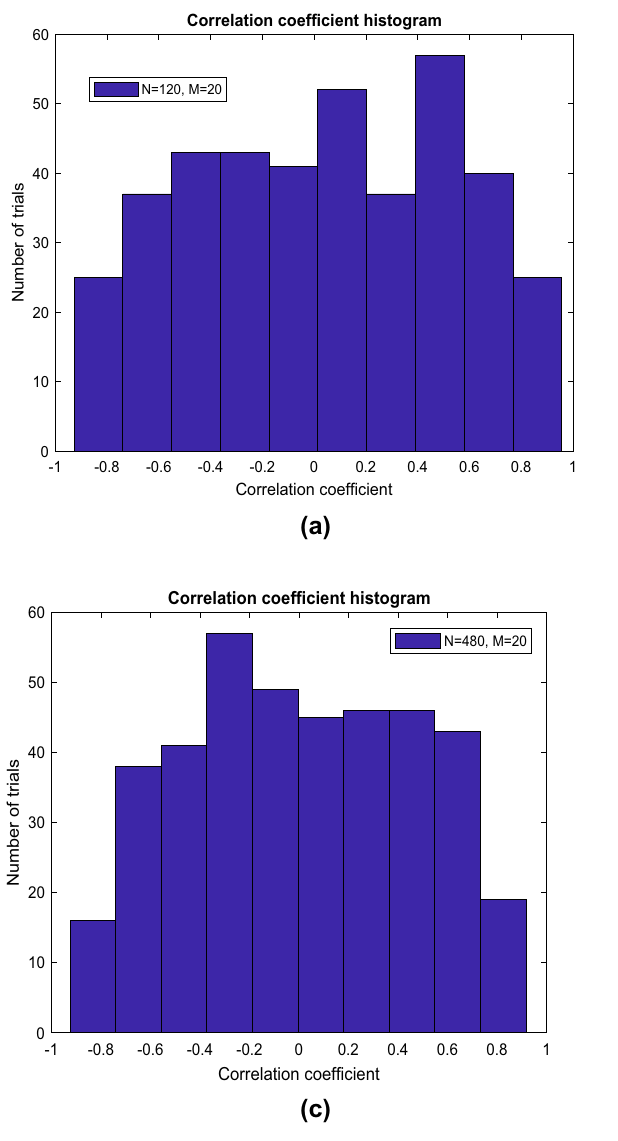
skewed towards − 1 or 1, but remain relatively uniform over the whole interval, which indicates no reliable estimation